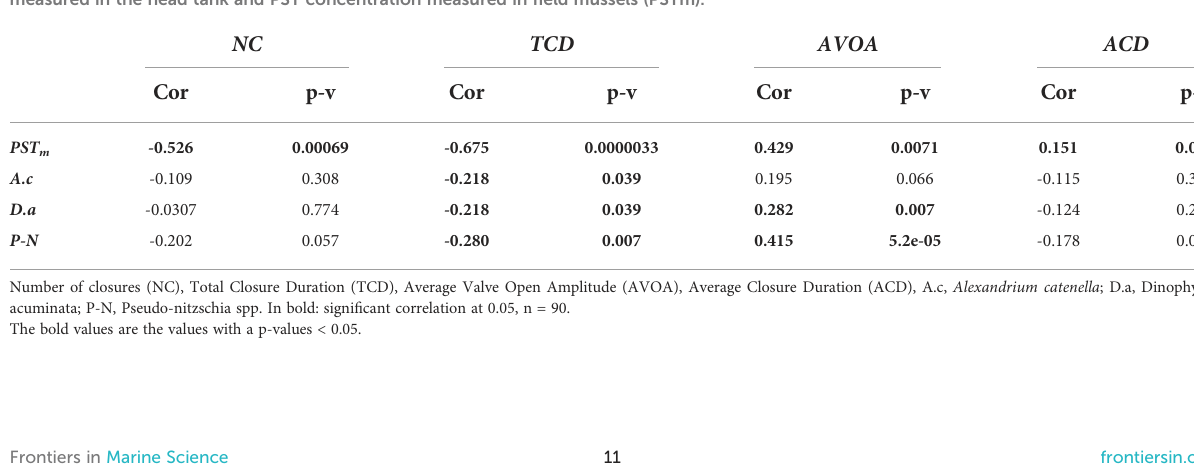
TABLE 3 Pearson correlation between the M. edulis gaping behaviour and the cells abundance (cells L -1 ) of toxic algae in natural seawater measured in the head tank and PST concentration measured in fi eld mussels (PSTm).